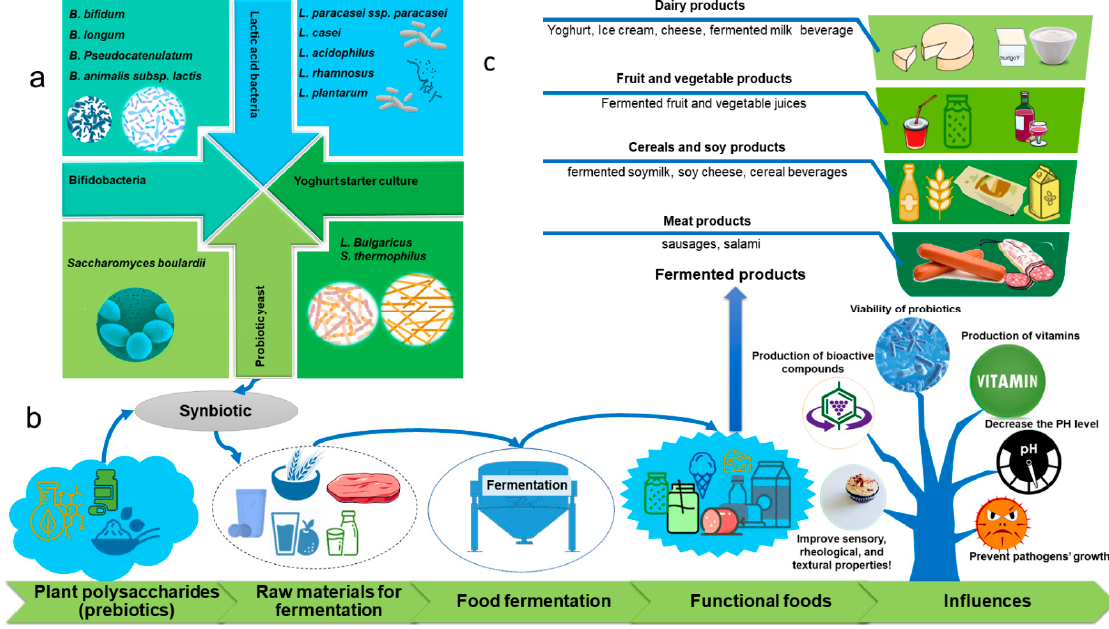
Figure 5. Schematic demonstration of the potential influence of plant polysaccharides in food fermentation. ( a ) probiotic bacteria most used in synbiotic fermentation, ( b ) fermentation process, ( c ) synbiotic fermented products with increased health benefits. Table 2. Influence of plant polysaccharides on probiotic viability in fermented food